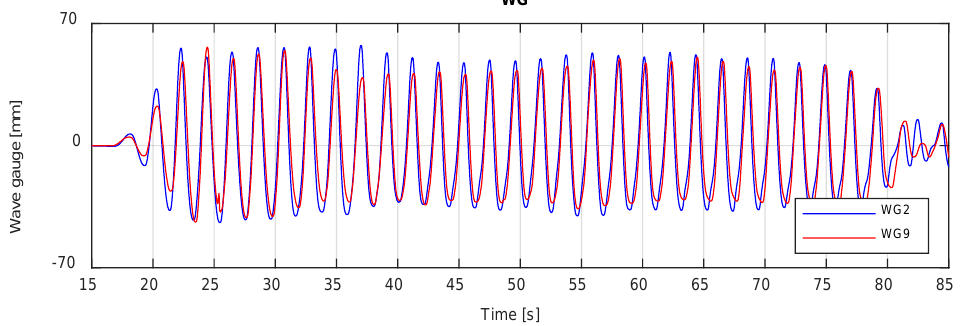
Figure 11. Wave height time series for 30 nonlinear regular waves measured by WG2 and WG9. The phase difference between WG2 and WG9 were eliminated manually (H14: d = 0.625 m, H = 0.1 m, and T = 2.1 s).